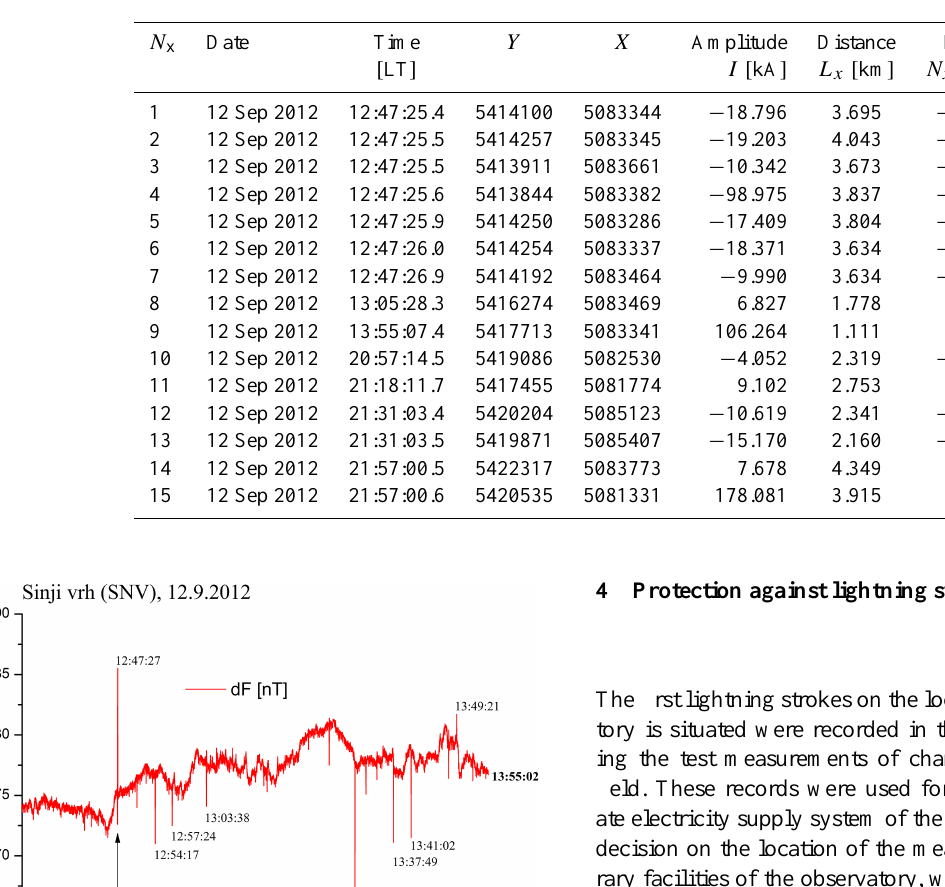
Table 2. Data on lightning strokes during the thunderstorm on Gora.